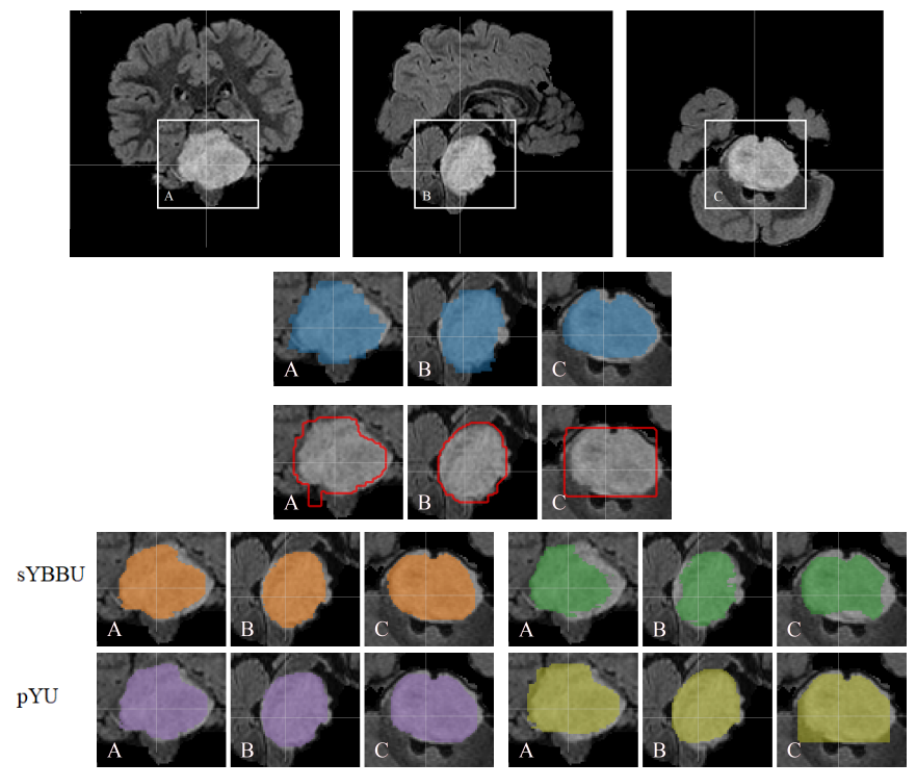
Figure 4. Segmentation results obtained on one case of DIPG are superimposed on the FLAIR back- ground. The top row displays the complete patient images. Ground truth mask in blue. Yolo detection contours in red. sYBBU Segmentation with FLAIR in orange. sYBBU Segmentation with T2w in green. pYU Segmentation with FLAIR in purple. pYU Segmentation with T2w in yellow. A: coronal, B: sagittal and C: